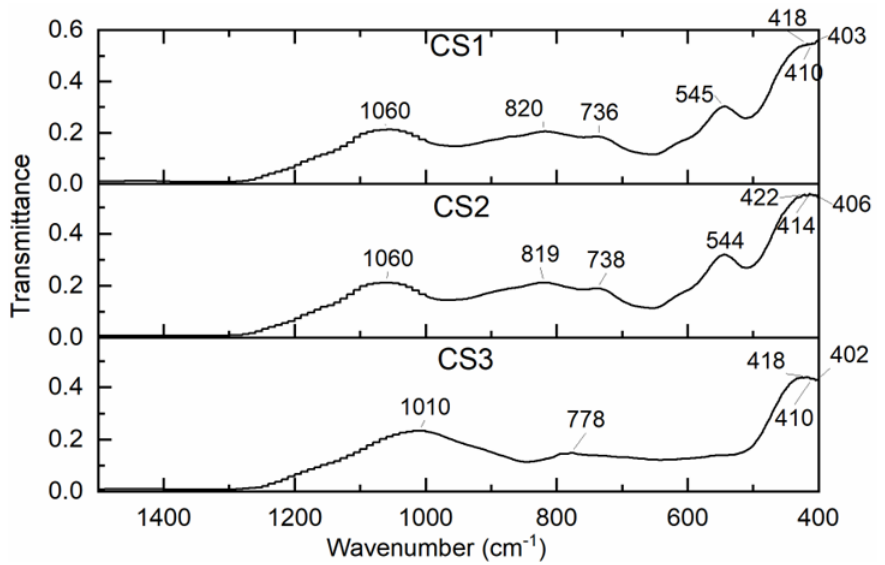
Figure 5. The FT-IR spectra of the cenospheres CS1, CS2, and CS3.